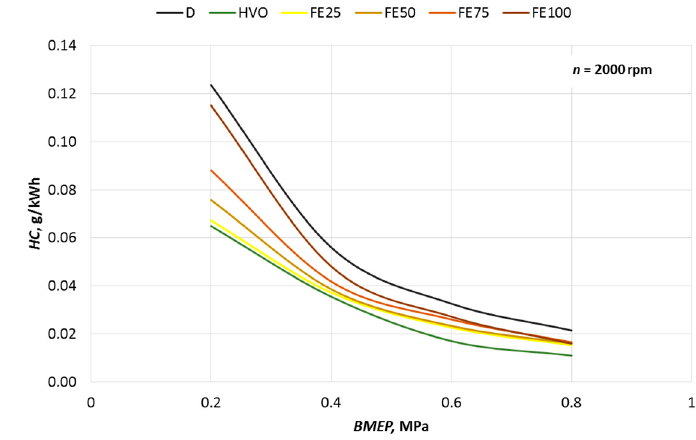
Figure 11. Dependence of hydrocarbon emissions on the load.